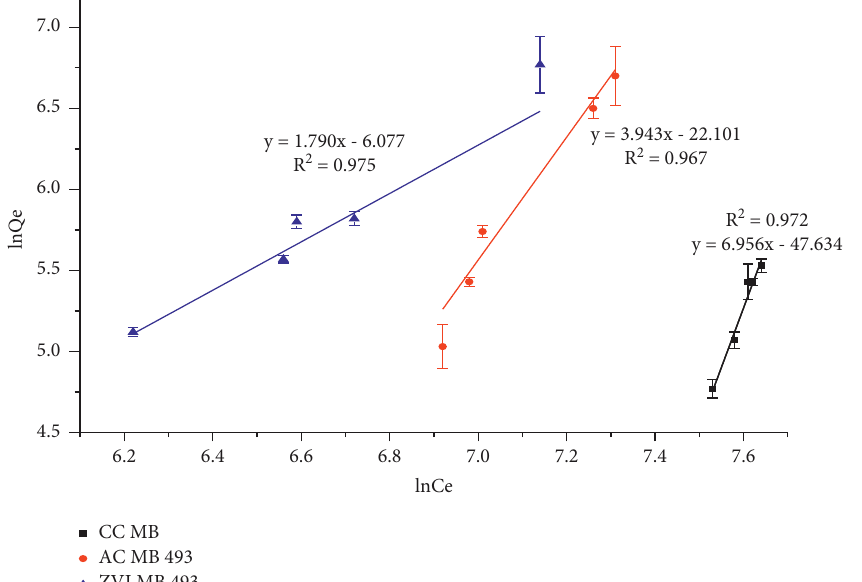
Figure 8: Freundlich adsorption isotherm for the removal of β -carotene onto CC MB, AC MB 493, and ZVI MB 493 at 75 ° C.